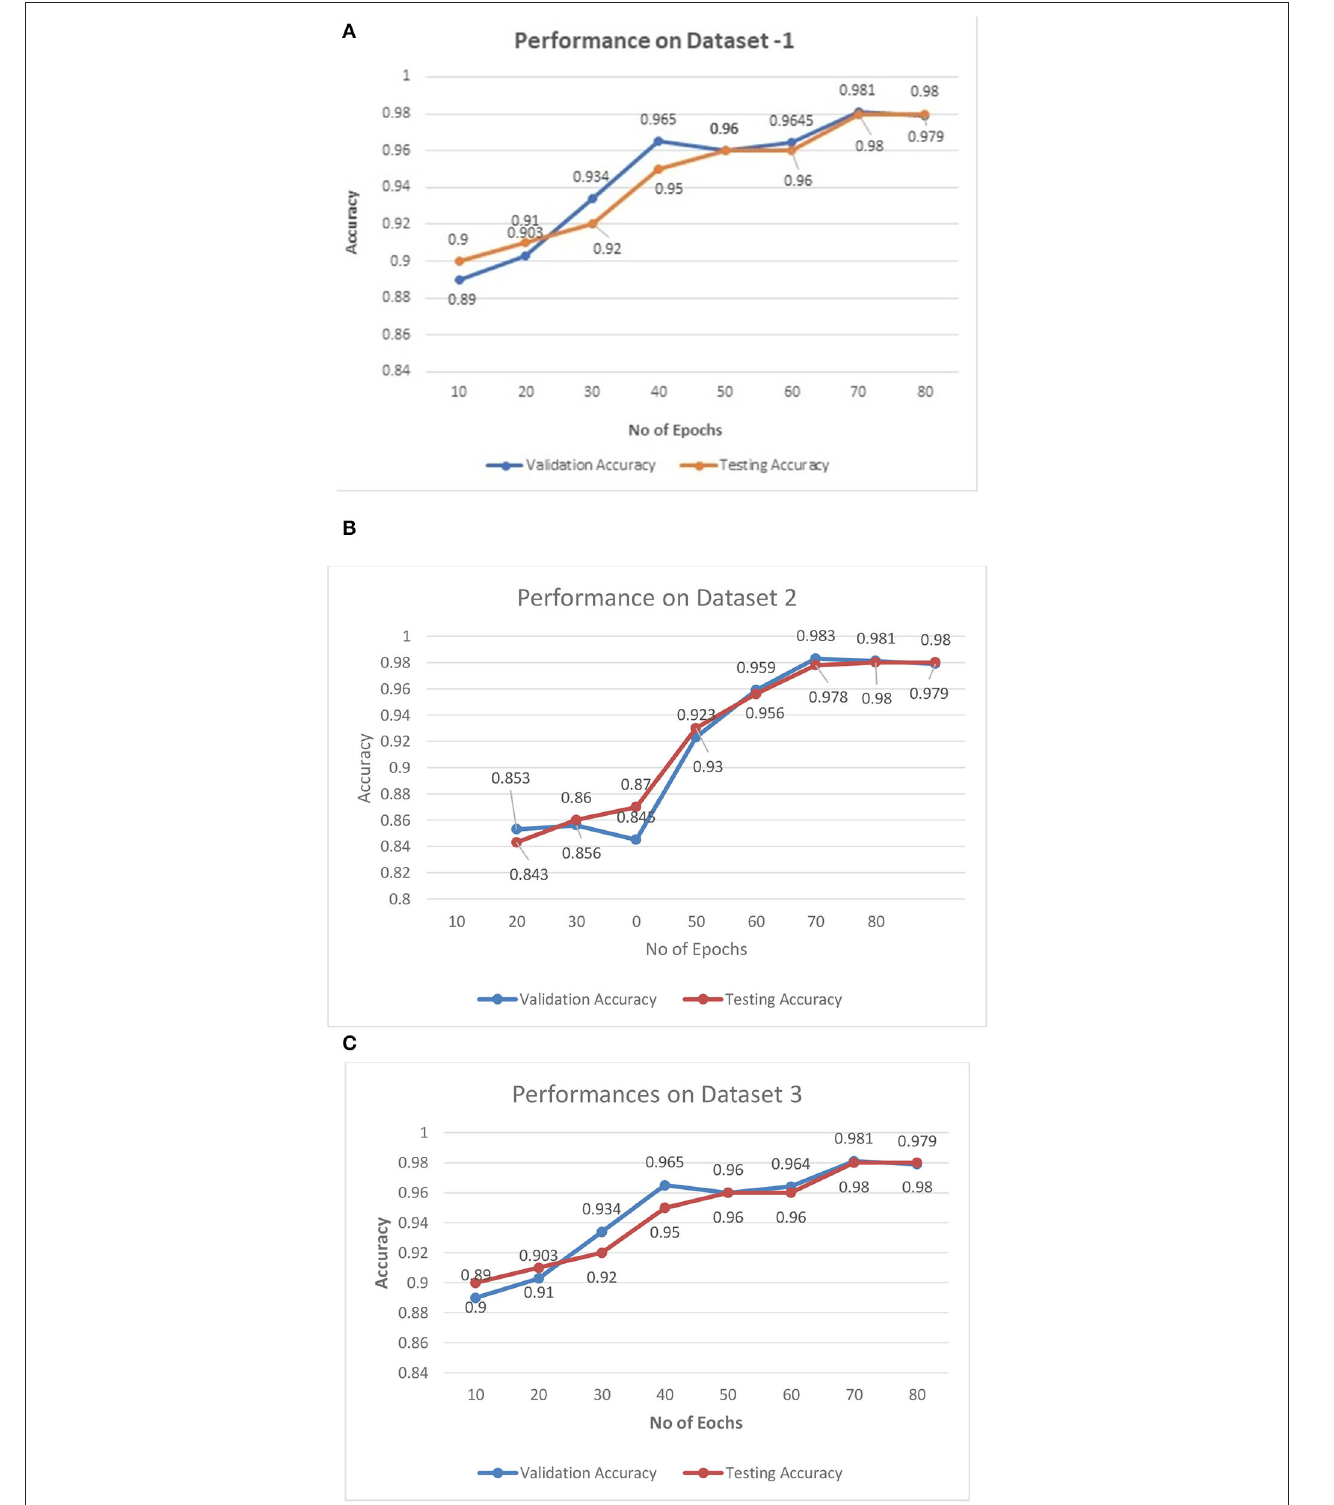
FIGURE 6 | (A–C) Training—validation curves for the proposed algorithm for different datasets.